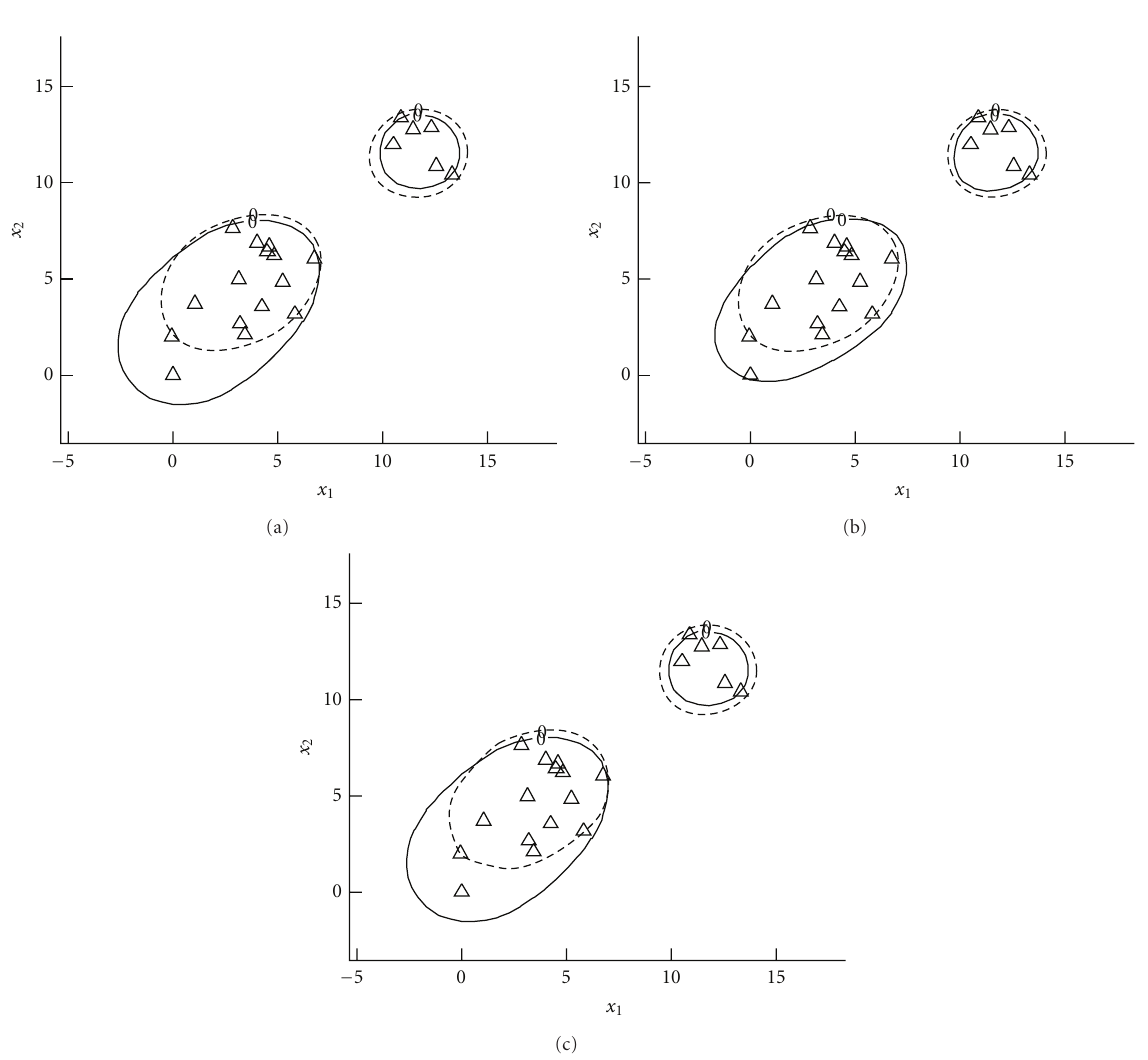
Figure 2: The contours f ( x , w ) = 0 by di ff erent values of η = 0, 0 . 5, 1 and by n =